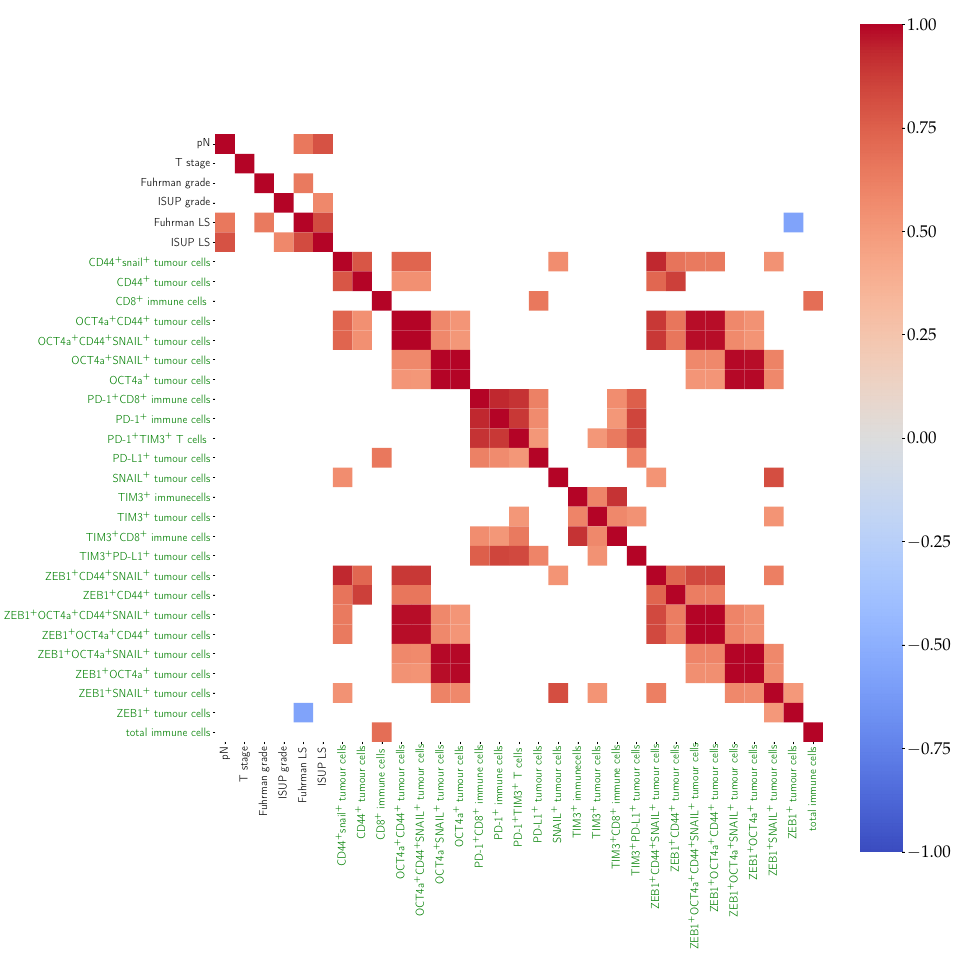
Figure 10. Heatmap showing positive (red), negative (blue), or no (white) correlation among mor- phological (black) and IF (green) markers in the WS cohort after unsupervised clustering. Features including OCT4a and ZEB1 showed the most correlation, while the only negative correlation was found between the Fuhrman LS and ZEB1 + tumour cells.